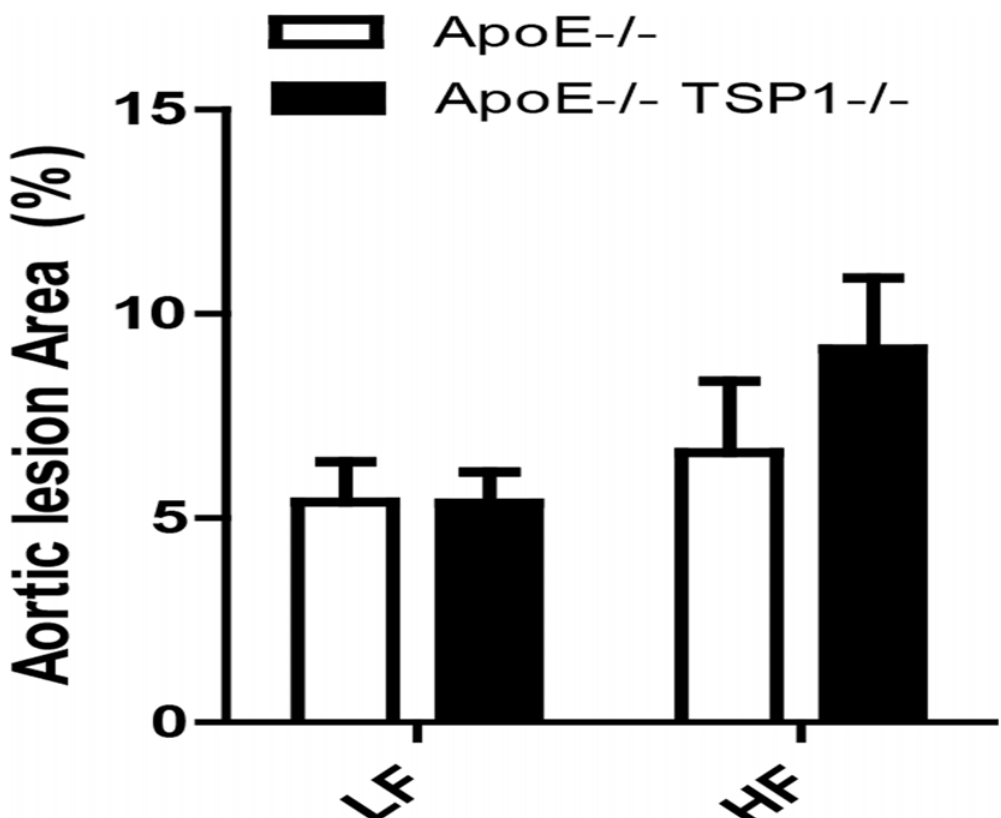
Fig 5. Effect of TSP1 deficiency on aortic lesion formation. Male ApoE-/-TSP1-/- mice and ApoE-/-mice were fed LF or HF diet for 16 weeks. Aortic lesion formation was analyzed by en face method. Data are represented as mean ± SE (n = 6 – 10 mice/group).